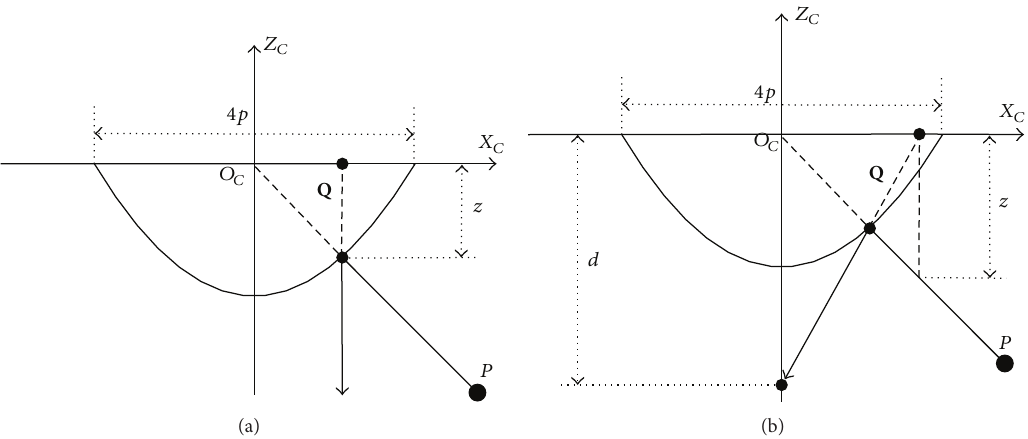
Figure 3: (a) The projection model of parabolic mirror. (b) The projection model of hyperbolic mirror.